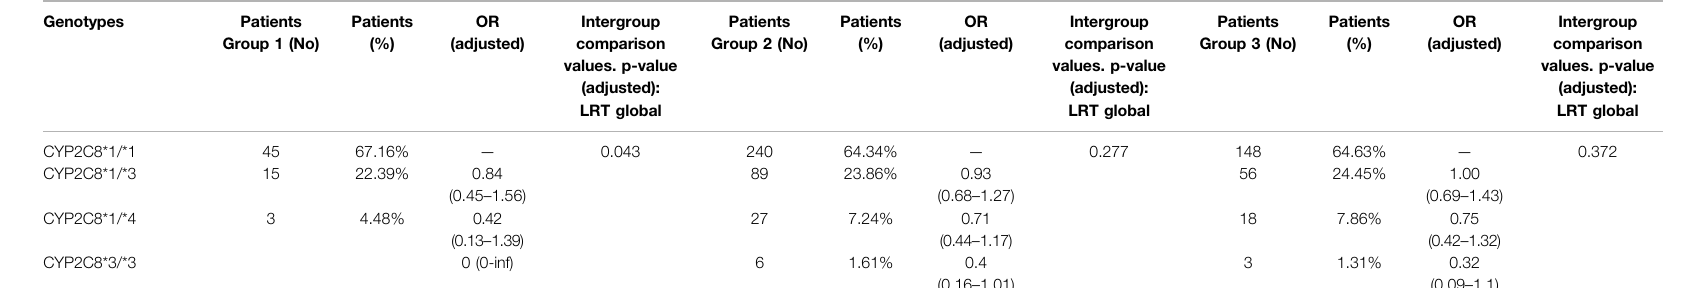
Patients Group 3 (No)